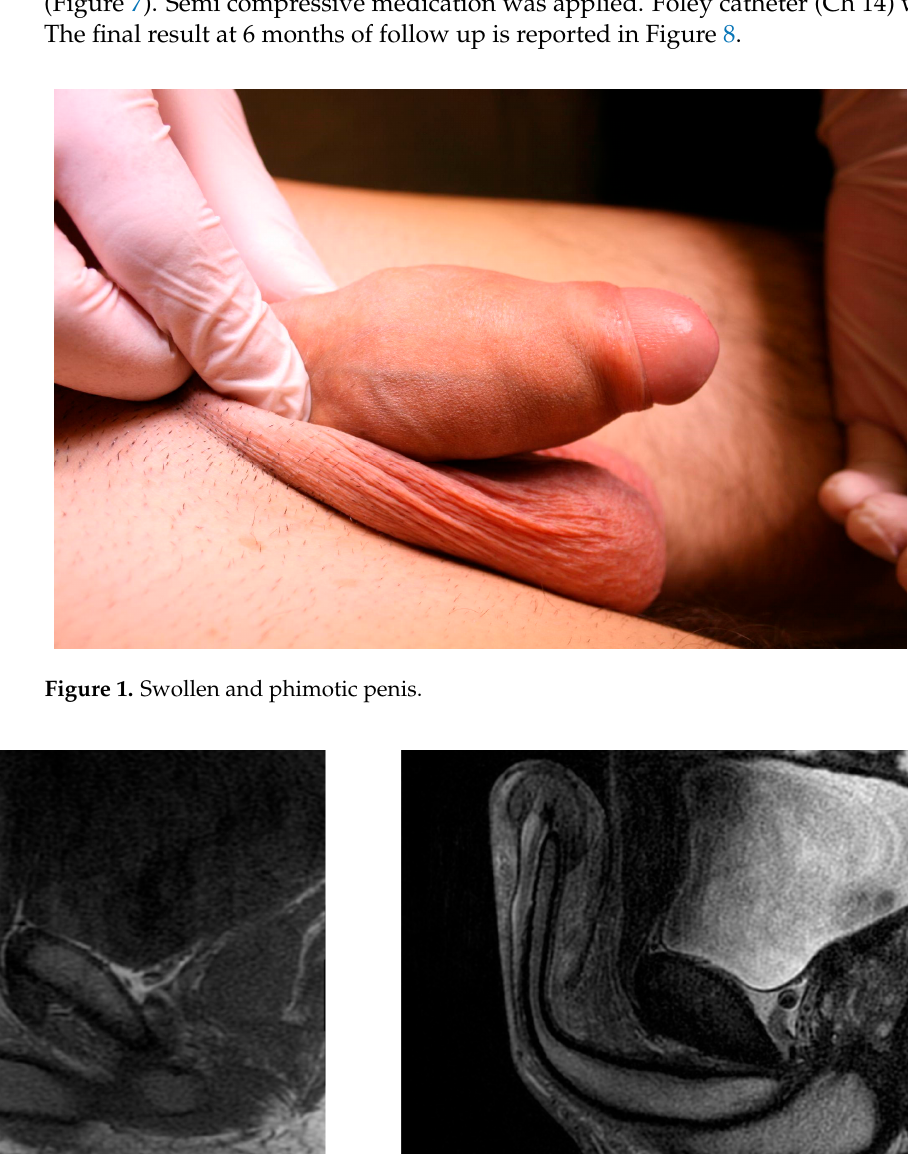
Figure 3. Excision of in fi ltrated tissues.